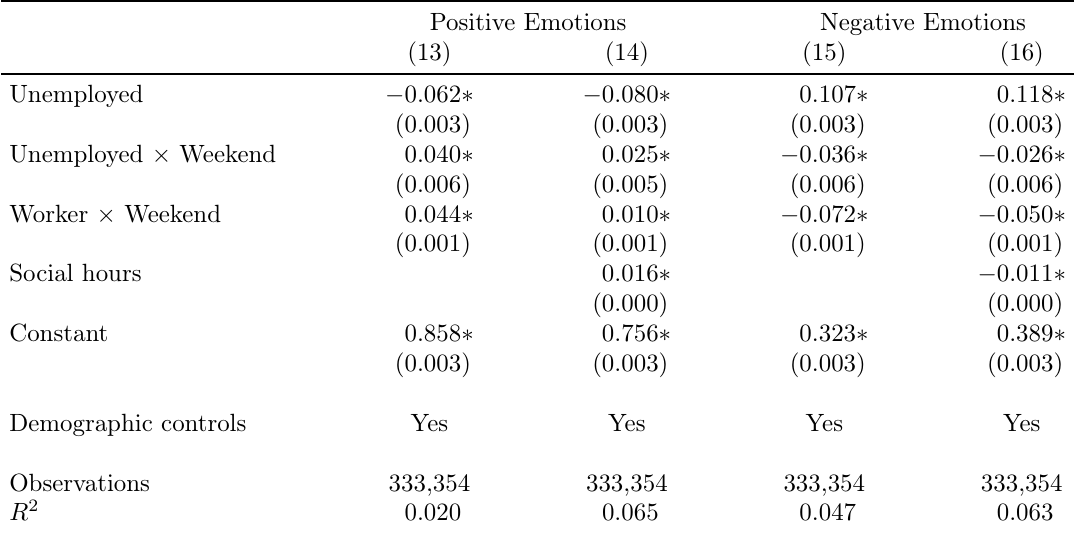
Table 4: Determinants of Well-Being, Including Social Hours Positive Emotions Negative